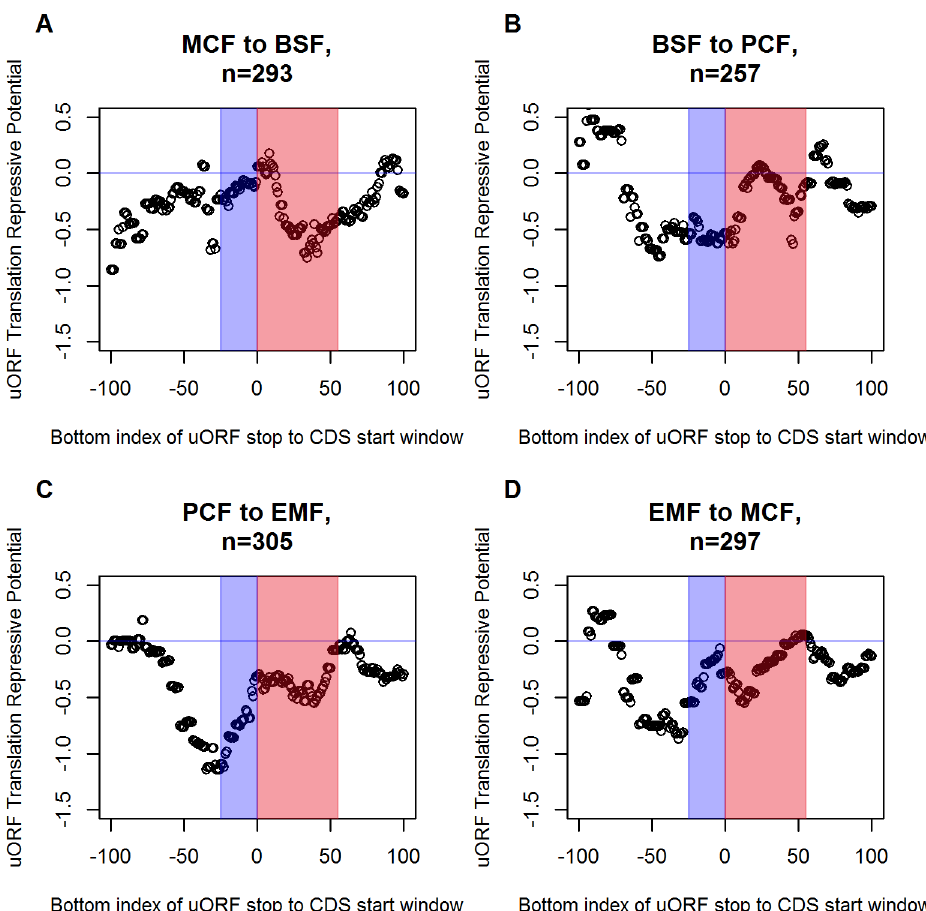
Fig 11. Repressive potential of uORFs depending on uORF stop to CDS start distance. Unlike the discontinuous evaluation of uORFs-to-CDS distance effect on translation efficiency in four panels of Fig 9 and Fig 10 (25 nt wide window, bottom border at -50, -10, 15 and 60 nt), this figure represents a continuous sequence of 201, 25 nt wide uORF-to-CDS distance window, sliding from -100 nt to 100 nt uORF-to-CDS distance range (x-axis). The y-axis represents translation repressive potential of the uORFs included in the respective uORF-to-CDS windows, calculated as the regression slope in Fig 9 and Fig 10. The blue box marks the farthest downstream window only including overlapping uORFs and plots close to maximum translation repression (min. y-value) in all four stages (see panels A to D ). Further downstream windows include less n numbers and cause noise artifacts. The red box indicates windows including uORFs with repressive potential. Only windows containing n > 5 uORFs are plotted to reduce noise. ( C ) Stage progression from PCF to EMF, which is promising to evaluate uORF effect on translation efficiency (see text), shows the gradual loss of translation repression when sliding the observation window